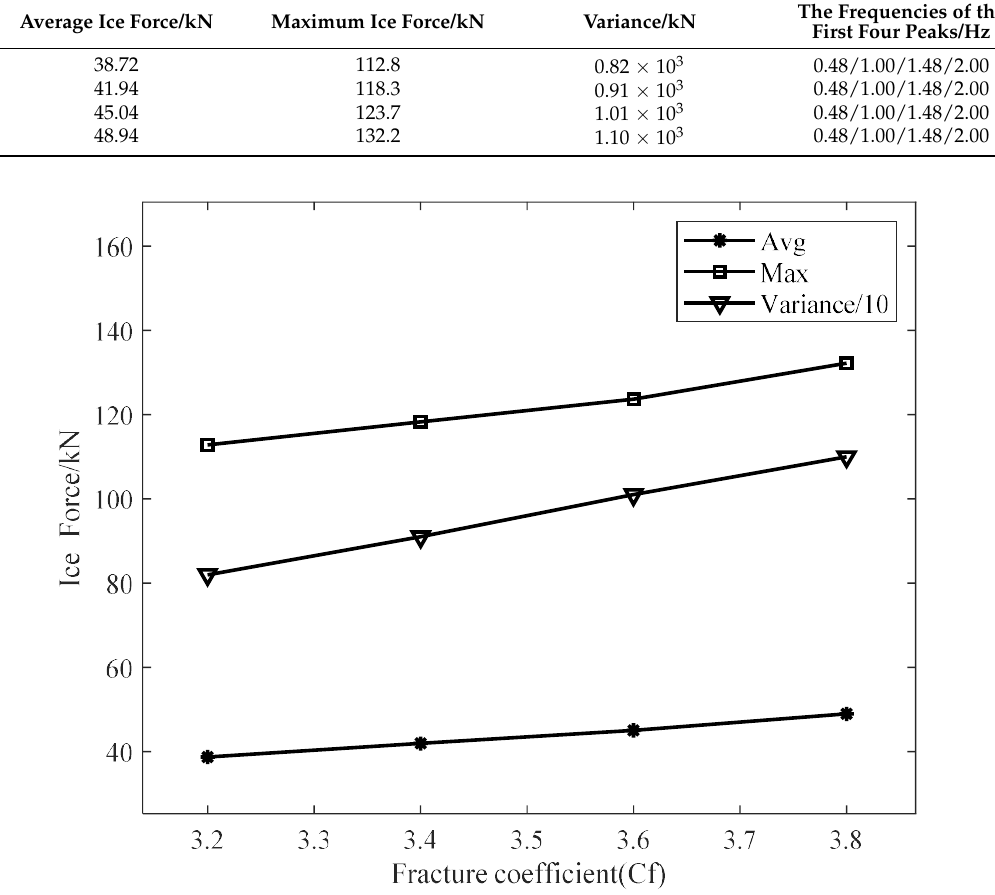
Figure 15. Change trend of variance and ice force with fracture coefficient ( C f ).